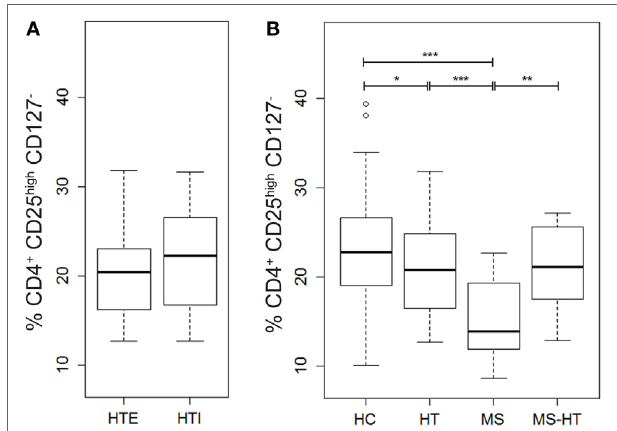
FigUre 3 | Percentage of Tregs, defined as CD4 + CD25 high CD127 − cells, in (a) hypothyroid (HTI) and euthyroid patients with Hashimoto’s thyroiditis (HTE) separately and in (B) healthy control (HC), Hashimoto’s thyroiditis (HT), multiple sclerosis (MS), and MS + HT. Differences between groups were evaluated by the Mann–Whitney U